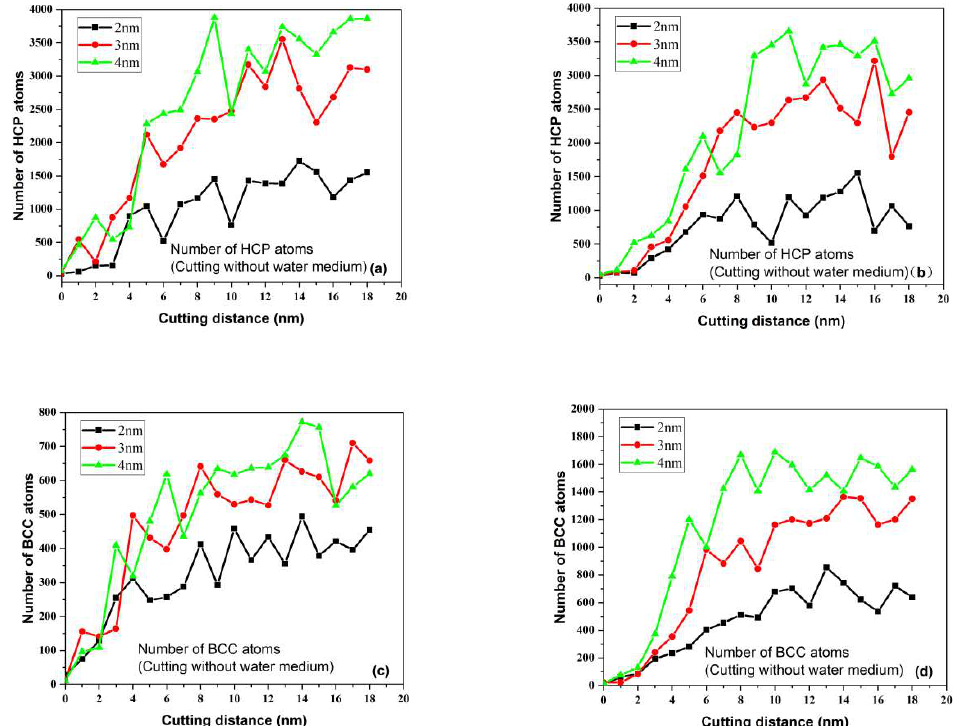
Figure 9. Crystal structure transition curves at different cutting depths. (( a ). number of HCP atoms at different cutting depths without water medium ( b ). number of HCP atoms at different cutting depths with water medium ( c ). number of BCC atoms at different cutting depths without water medium ( d ). number of BCC atoms at different cutting depths with water